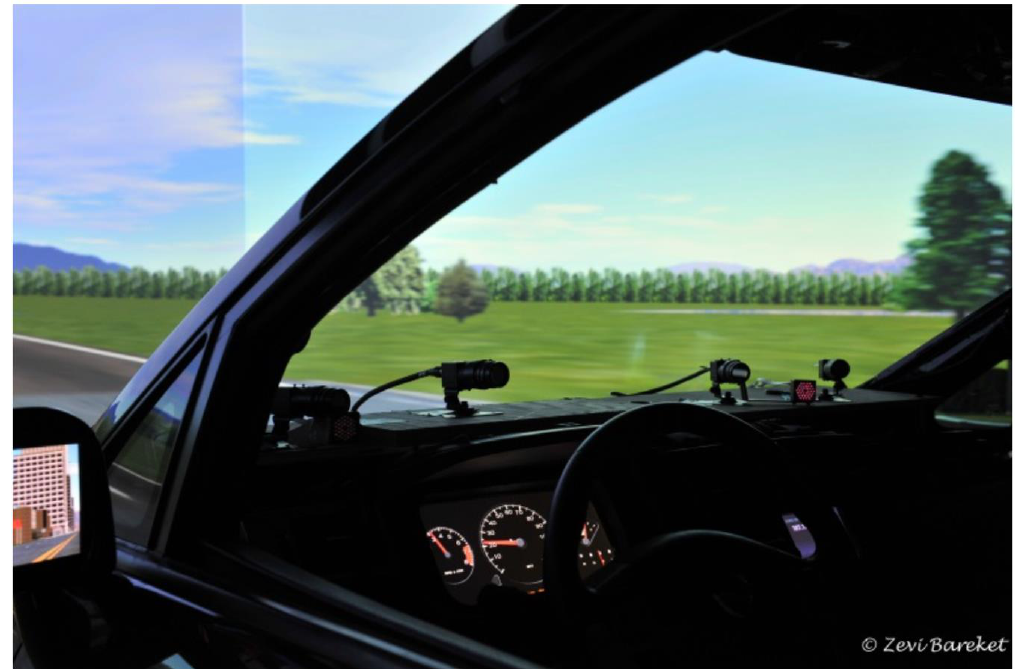
Figure 2. A SmartEye four-camera eye-tracking system in a virtual driving simulator environment (http://www.umtri.umich.edu/what-we-offer/driving-simulator, accessed on 18 March 2020, with permission given from University of Michigan Transportation Institute (UMTRI) [56] .